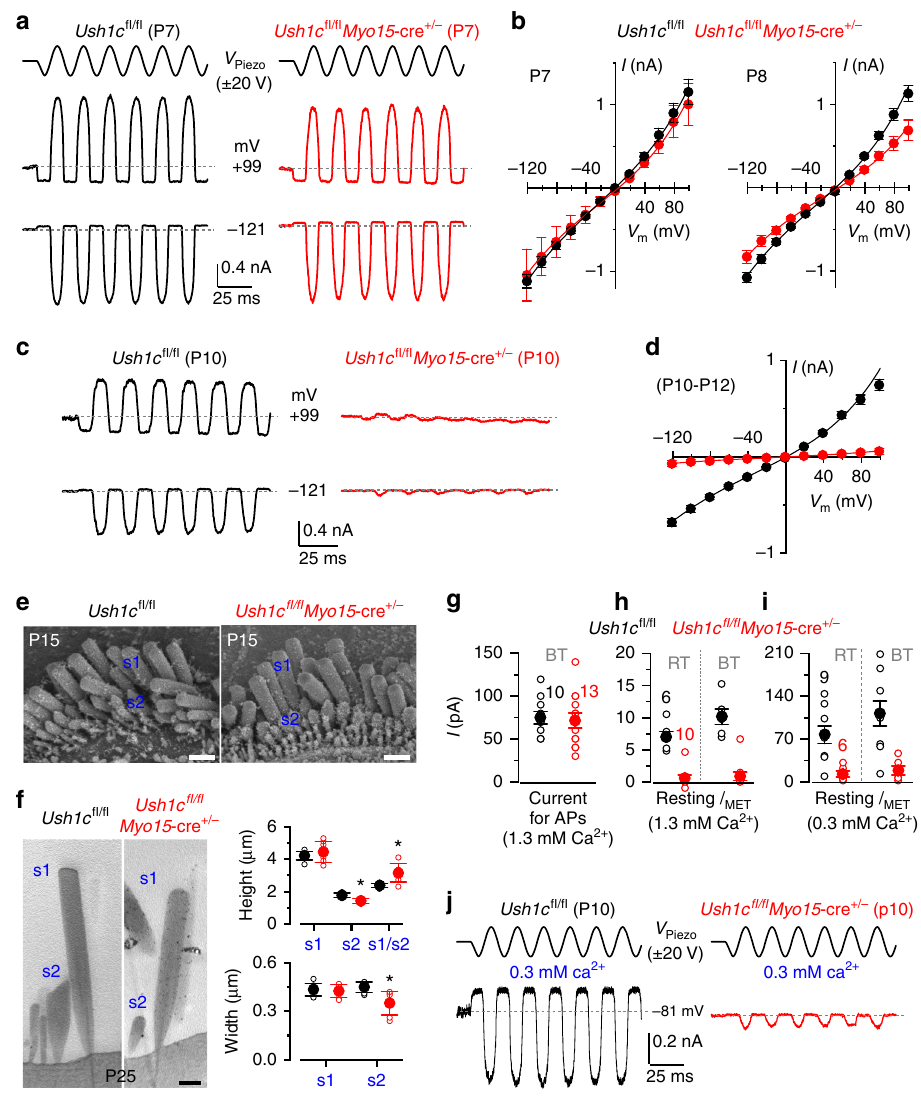
Fig. 2 Disappearance of the MET current in IHCs of Ush1c fl / fl conditional KO mice. a MET currents recorded in P7 IHCs from control Ush1c fl / fl and knockout Ush1c fl / fl Myo15 -cre + /- mice by displacing the hair bundles while applying 20 mV voltage steps between − 121 mV to + 99 mV. For clarity, only the traces at − 121 mV and + 99 mV are shown (dashed lines: holding current; V fl uid jet). b Maximum MET current-voltage curves obtained Piezo : driver voltage to the from P7 (left) and P8 (right) Ush1c fl / fl and Ush1c fl / fl Myo15 -cre + /- IHCs (3 and 6 mice, respectively). c MET currents in P10 IHCs from both genotypes. Protocol as in a . d Maximum MET currents obtained from 9 Ush1c fl / fl and 17 Ush1c fl / fl Myo15 -cre + /- (P10-P12) IHCs (4 and 8 mice, respectively). e SEM images of P15 IHC bundle from both genotypes. Scale bars, 1 μ m. f TEM images (left) of P25 IHC stereocilia from both genotypes. Scale bars, 400 nm. Right panels show the height and width of the tallest (s1) and second tallest (s2) stereocilia in P25 IHCs from Ush1c fl / fl and Ush1c fl / fl Myo15 -cre + /- mice. g Depolarizing current used to elicit repetitive APs in Ush1c fl / fl (P9-P10, 8 mice) and Ush1c fl / fl Myo15 -cre + /- (P9-P11, 7 mice) IHCs. Experimental conditions: body temperature (BT: 34 – 37 °C); 1.3 mM extracellular Ca 2 + . h Size of the resting MET current ( I MET ) recorded from Ush1c fl / fl IHCs (P9-P11, 2 mice) and Ush1c fl / fl Myo15 -cre + /- (P10-P11, 5 mice) IHCs. Room temperature (RT: 22 – 24 °C, left bars); 1.3 mM extracellular Ca 2 + . I MET was interpolated from its current-voltage relation near the V m of IHCs ( − 73 mV). Right bars show the RT values corrected for BT using a Q 10 of 1.45 (ref. 8 ). i Size of the resting I MET at − 73 mV from Ush1c fl / fl (P10, 3 mice) and Ush1c fl / fl Myo15 -cre + /- (P10, 3 mice) IHCs using the endolymph-like Ca 2 + concentration (0.3 mM: see panel j ). Left and right bars are as described in h . j I MET recorded at − 81 mV at P10 from Ush1c fl / fl and Ush1c fl / fl Myo15 -cre + /- IHCs in 0.3 mM Ca 2 + . Protocol as in a . Number of IHCs in g – i is shown above the columns. Average data is shown as mean ± SEM in b , d , g , h or mean ± SD in